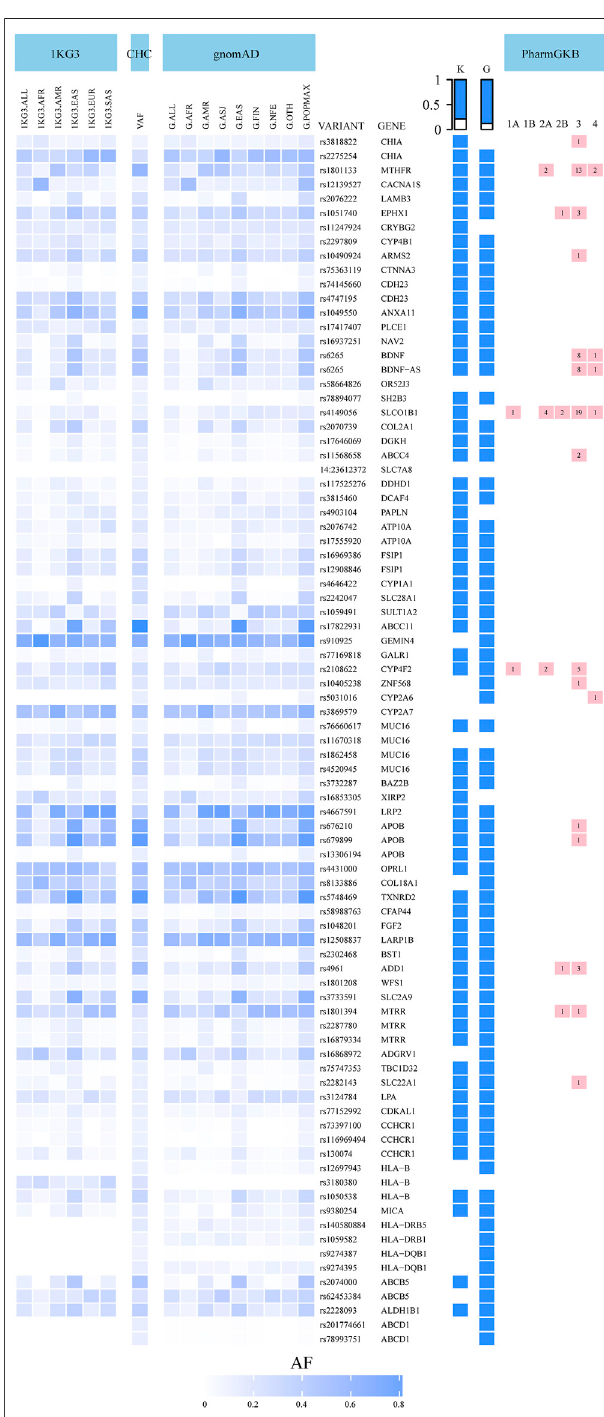
FIGURE 2 | Allele frequencies of 85 most common potentially deleterious variants in the central Han Chinese population compared to global